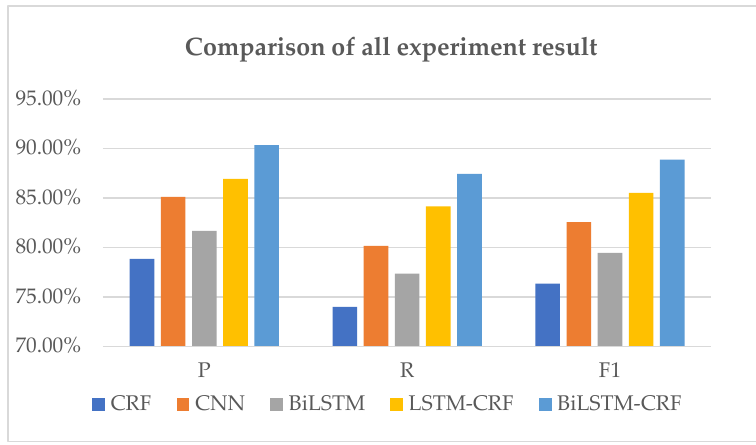
Figure 5. Entity recognition model comparison results.